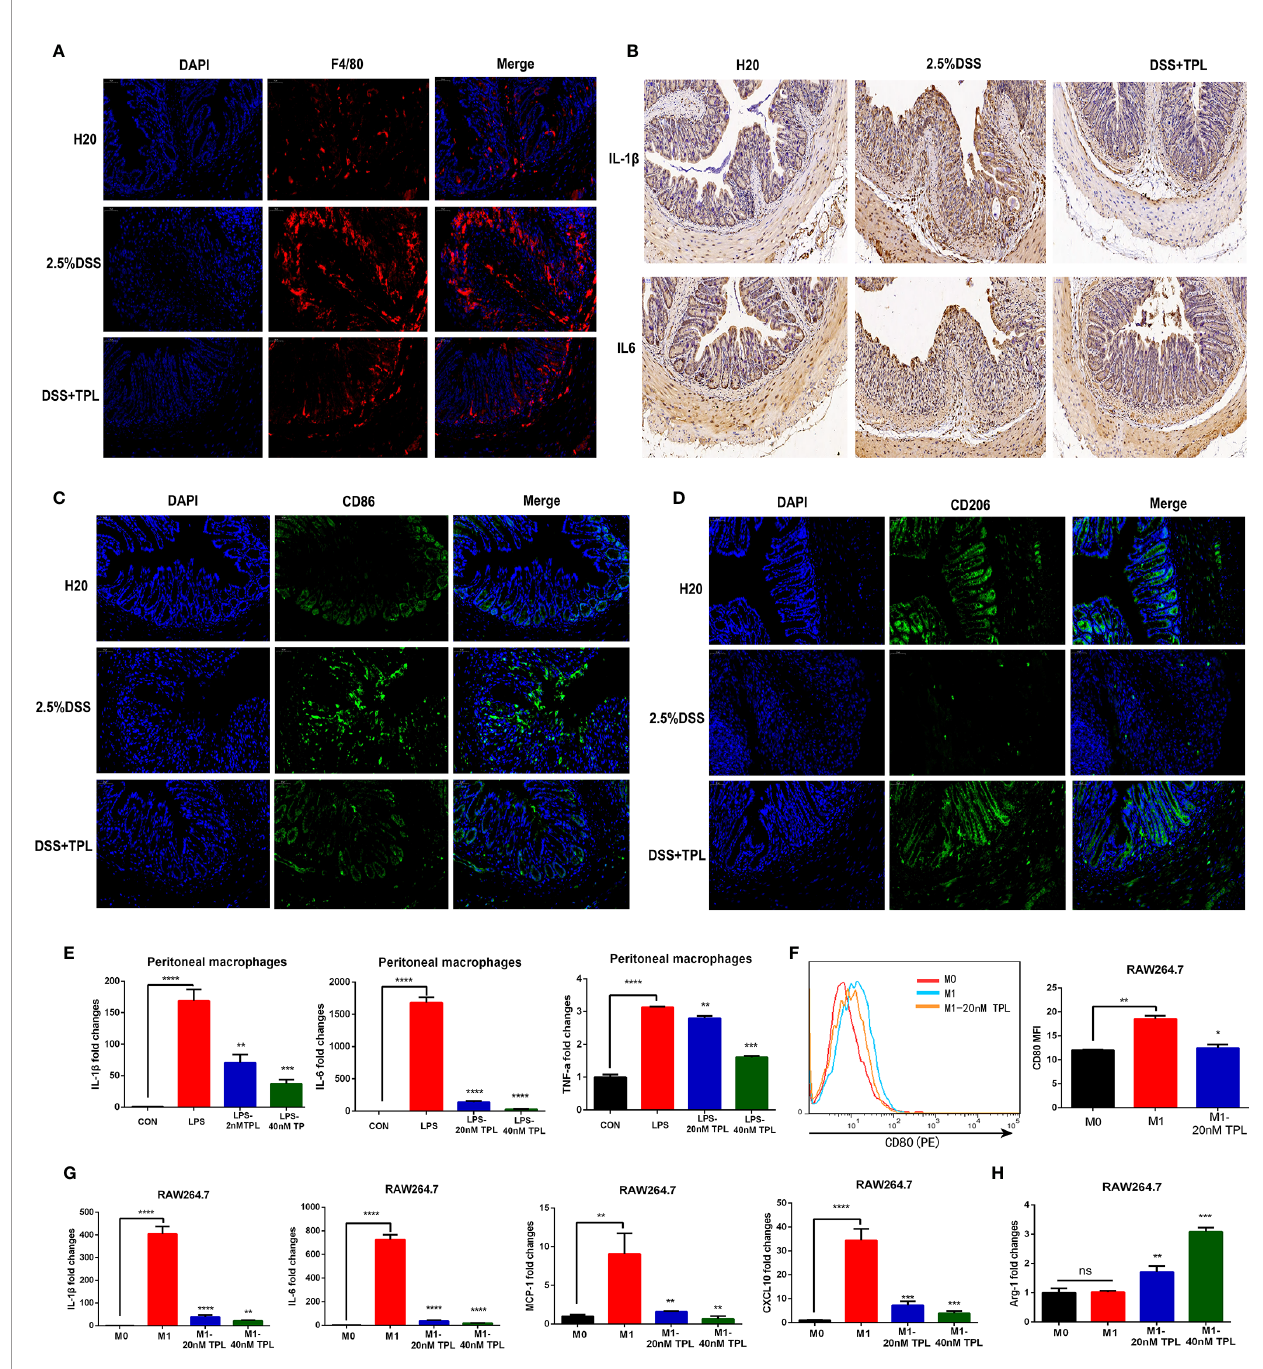
FIGURE 2 | Triptolide inhibited macrophage in fi ltration and in fl ammatory cytokines in vivo and in vitro . Mice aged 6 – 8 weeks were treated with 2.5% DSS with or without triptolide administration. (A) The F4/80 expression was measured by immuno fl uorescence assay. (B) The IL-1 b and IL-6 level of colitis was detected by immunohistochemistry assay. RAW 264.7 macrophages were treated with 1,000 ng/ml lipopolysaccharide (LPS) with 0 – 40 nM triptolide for 24 h. (C) The CD86 expression was measured by immuno fl uorescence assay. (D) The CD206 expression was measured by immuno fl uorescence assay. (E) RT-qPCR was used to measure the levels of proin fl ammatory cytokines such as IL-1 b , IL-6, and TNF- a . RAW 264.7 macrophages were treated with 500 ng/ml LPS and 100 ng/ml IFN g , then incubated with 0 – 40 nM triptolide for 24 h. (F) Flow cytometry was performed to determine the expression of CD80, a M1-mediated surface marker. (G) RT- qPCR was used to measure the levels of M1-mediated cytokines such as IL-1 b , IL-6, MCP-1, and CXCL10. (H) RT-qPCR was used to measure the levels of M2- mediated cytokines including Arg-1. b -actin served as an internal control. Data are shown as the mean ± SD of at least three independent experiments. *P < 0.05; **P < 0.01; ***P < 0.001; ****P < 0.0001; and ns means no signi fi